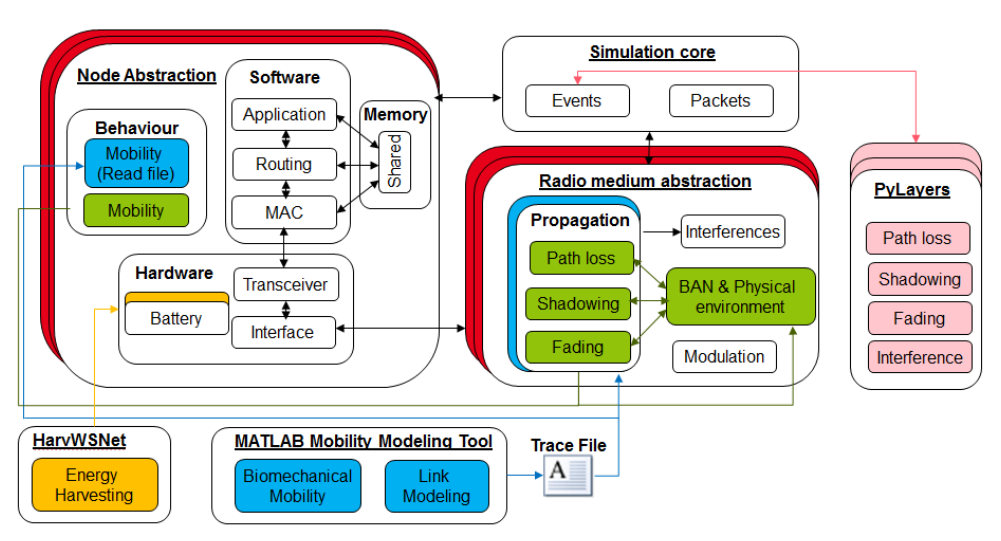
Figure 1. Adaptation of the WSNet simulator to BAN/body-to-body networks (BBN)